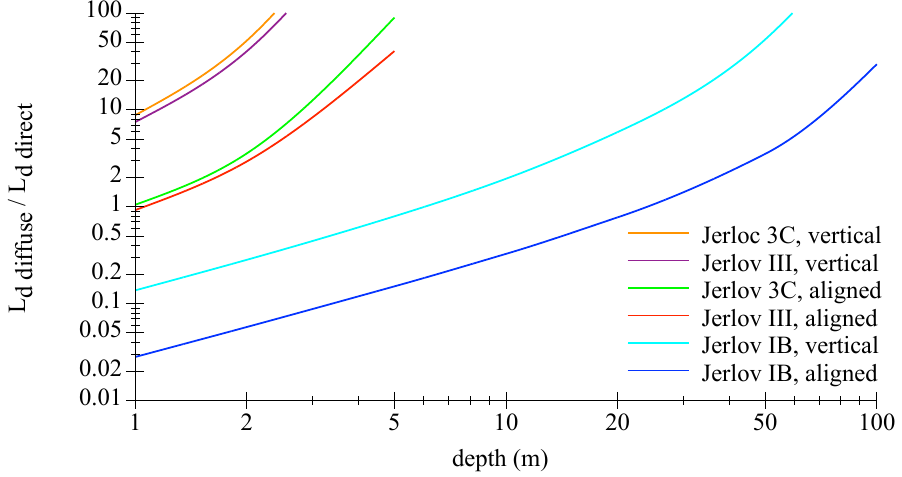
Figure 3. Graphic showing the ratio of the diffuse to the direct radiances as function of the water depth for Jerlov water types IB, III, 3C for a sensor looking vertical upwards or aligned direct to the sun. Data were generated with Hydrolight for a specific wavelength of 450 nm.